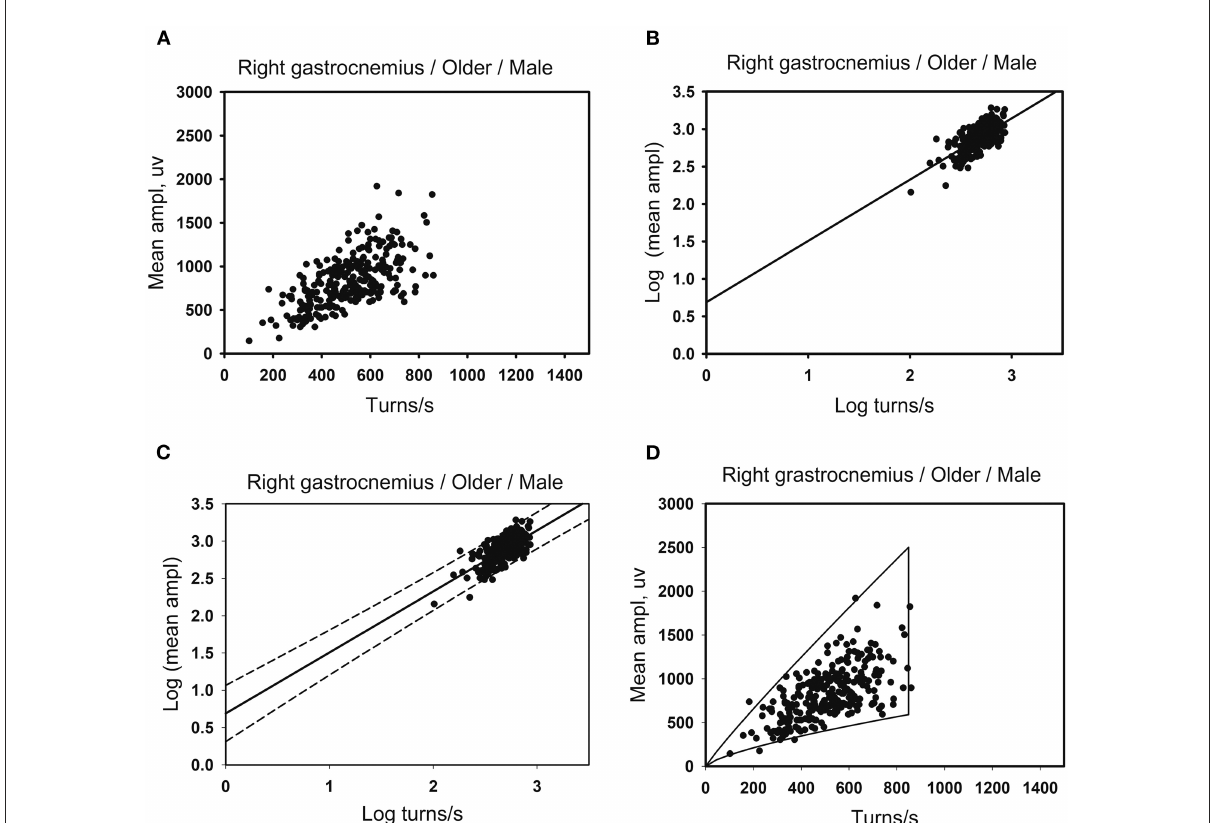
FIGURE1 Developing method of the linear regression clouds. (A) There are 260 data points for the right gastrocnemius muscles in the older men. Scatter plots are made using the number of turns per second and the mean amplitude. (B) Take lg (number of turns per second) as the independent variable and lg (mean amplitude) as the dependent variable for linear correlation analysis. A linear regression relationship exists between the two variables, with the linear regression equation of Y = a + b*X. (C) The standard error of intercept and slope of the linear regression equation are used to determine the upper and the lower boundaries of the cloud that contains the prediction interval of the mean amplitude corresponding to the number of turns per second. (D) After exponentiating the logarithm, the original data of the number of turns per second is used as the independent variable. The standard error of the intercept and slope are substituted into the linear regression equation. Each independent variable (the number of turns per second) has two corresponding dependent variables (the mean amplitude), as the upper and lower boundaries of the clouds. And the 99th percentile of the number of turns per second as the right boundaries of the